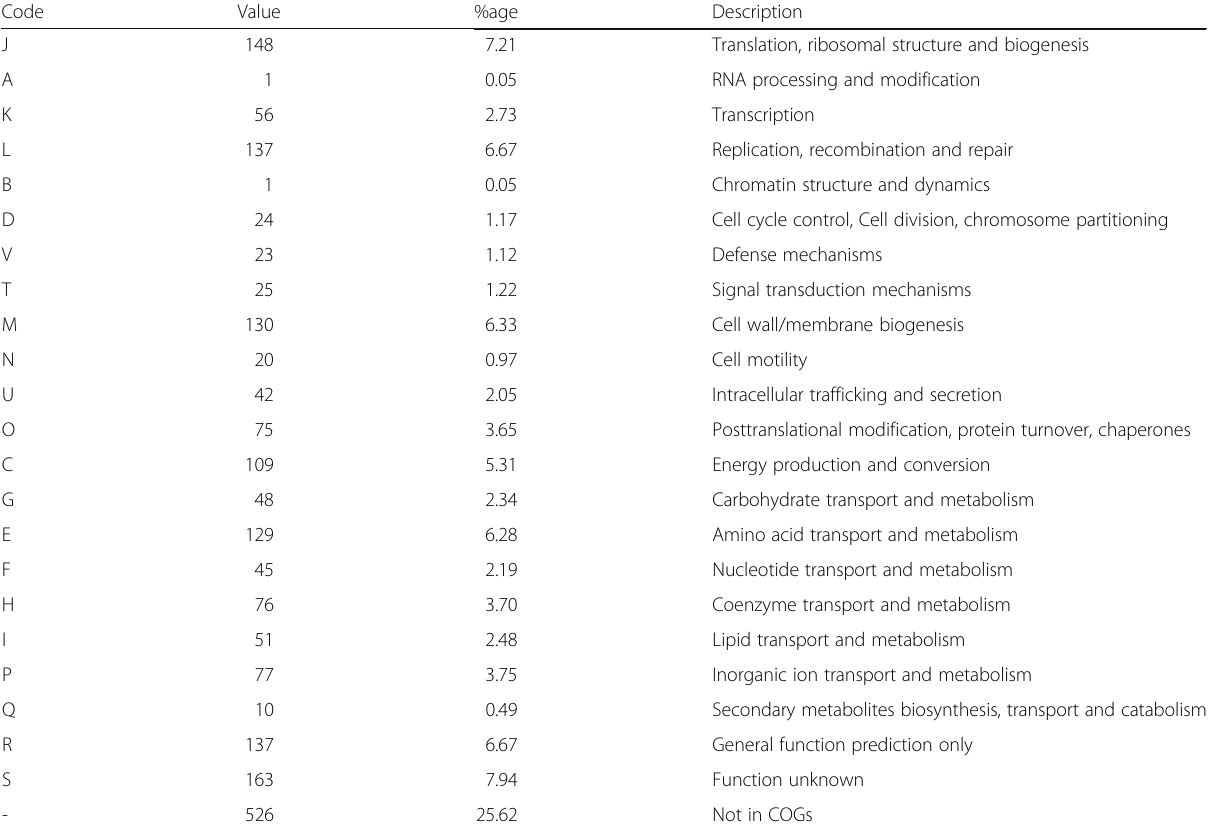
Table 4 Number of predicted genes associated with general COG functional categories Code Value